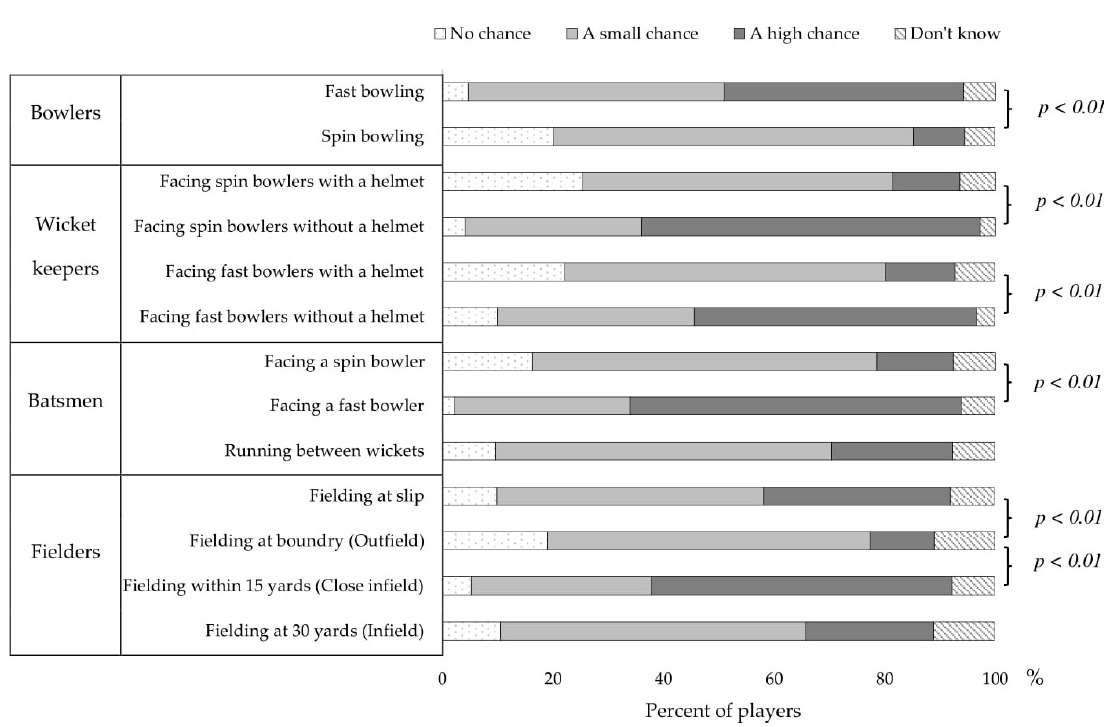
Figure 1. Injury risk perceptions in cricket-specific tasks at different playing positions. Note : p values were calculated comparing the median scores between selected response variables using Wilcoxon signed rank test.